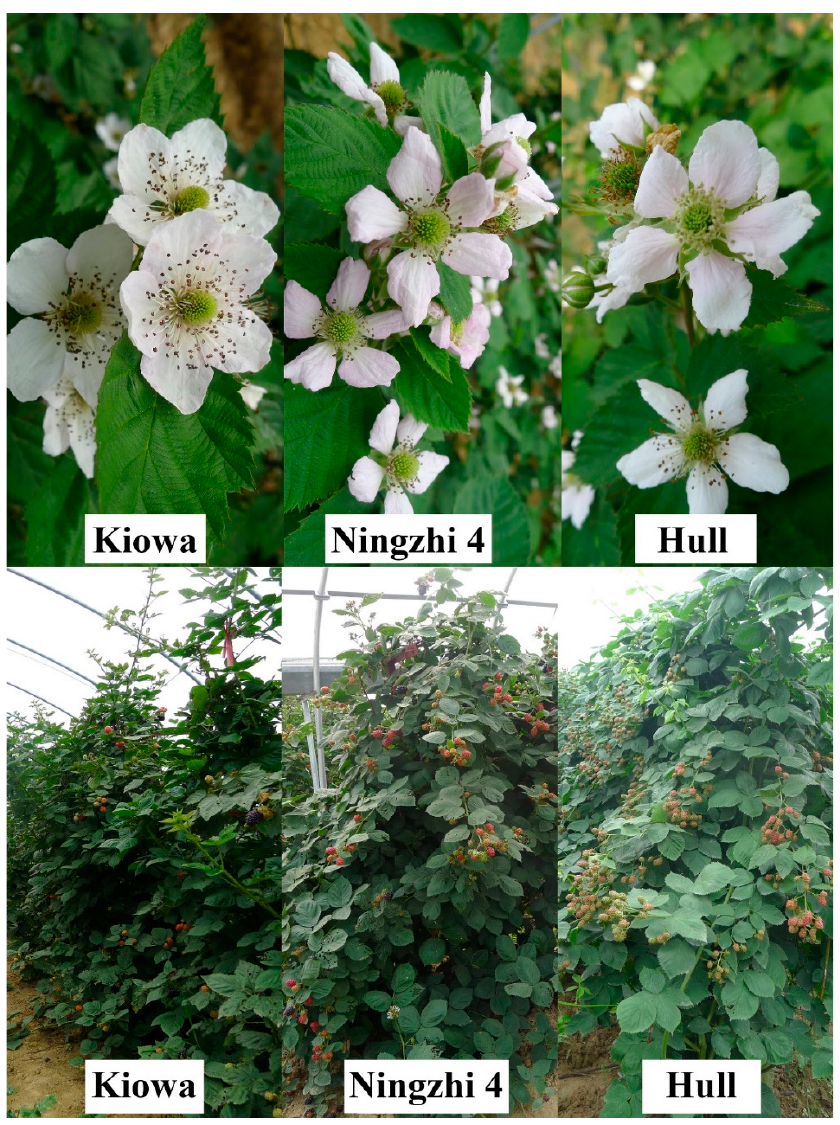
Figure 1. ‘Kiowa,’ ‘Ningzhi 4 ′ and ‘Hull thornless’ blackberry of fl ower morphology and fruiting. Figure 1. ‘Kiowa’, ‘Ningzhi 4’ and ‘Hull thornless’ blackberry of flower morphology and